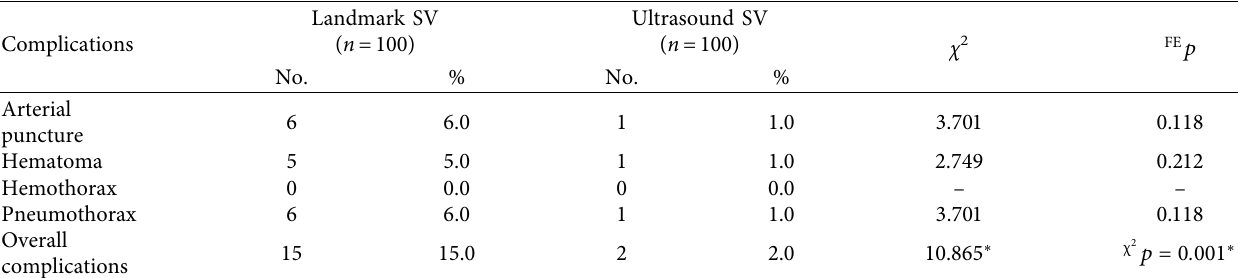
Table 7: Comparison between landmark and ultrasound in SV group (B) according to complications.